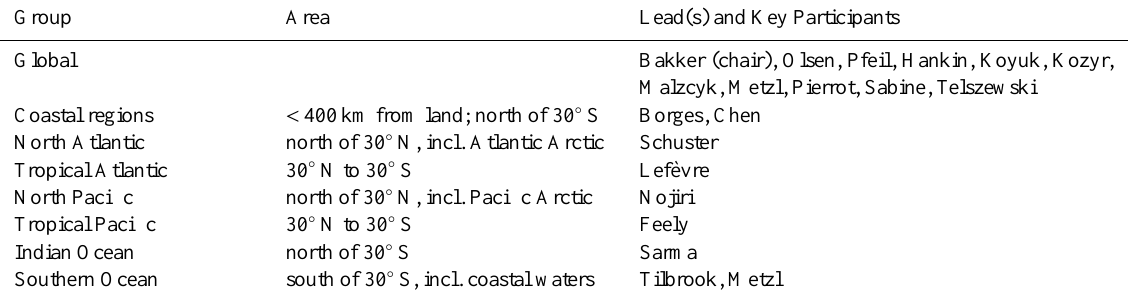
Table 2. Groups and key participants in SOCAT. Figure 3 shows the SOCAT regions. Group Area Lead(s) and Key Participants Global Bakker (chair), Olsen, Pfeil, Hankin, Koyuk, Kozyr, Malzcyk, Metzl, Pierrot, Sabine, Telszewski Coastal regions < 400km from land; north of 30 ◦ S North Atlantic north of 30 ◦ N, incl. Atlantic Arctic Schuster Tropical